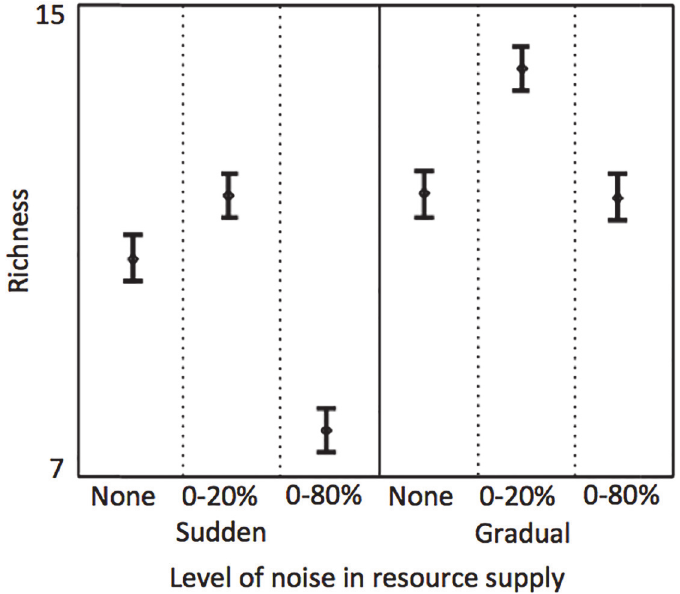
Fig 3. Averaged species richness (bars are 95% confidence interval) in the self-organized phytoplankton assemblages ( n = 100) for the scenarios where reversals in the resource supply concentrations were sudden (left) and gradual (right), each at the three levels of noise in the resource supply. Data for richness data are provided as supplementary material (S1 Data).